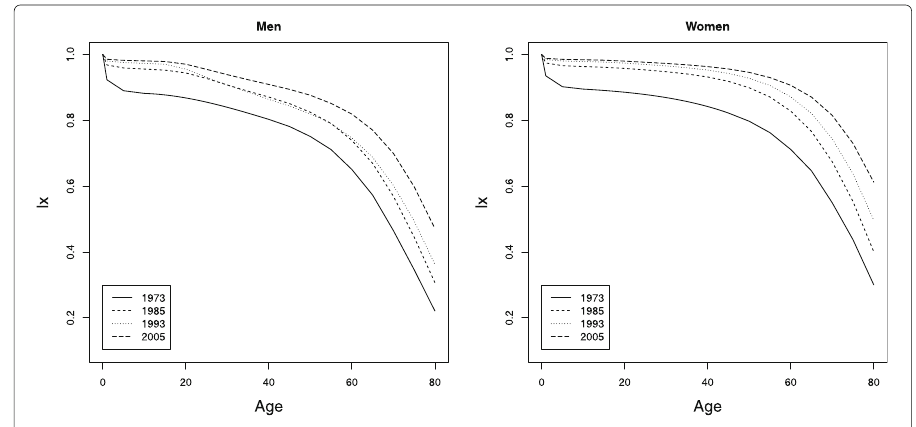
Fig. 13 Evolution of the survival curve, Colombia, census years, men and women